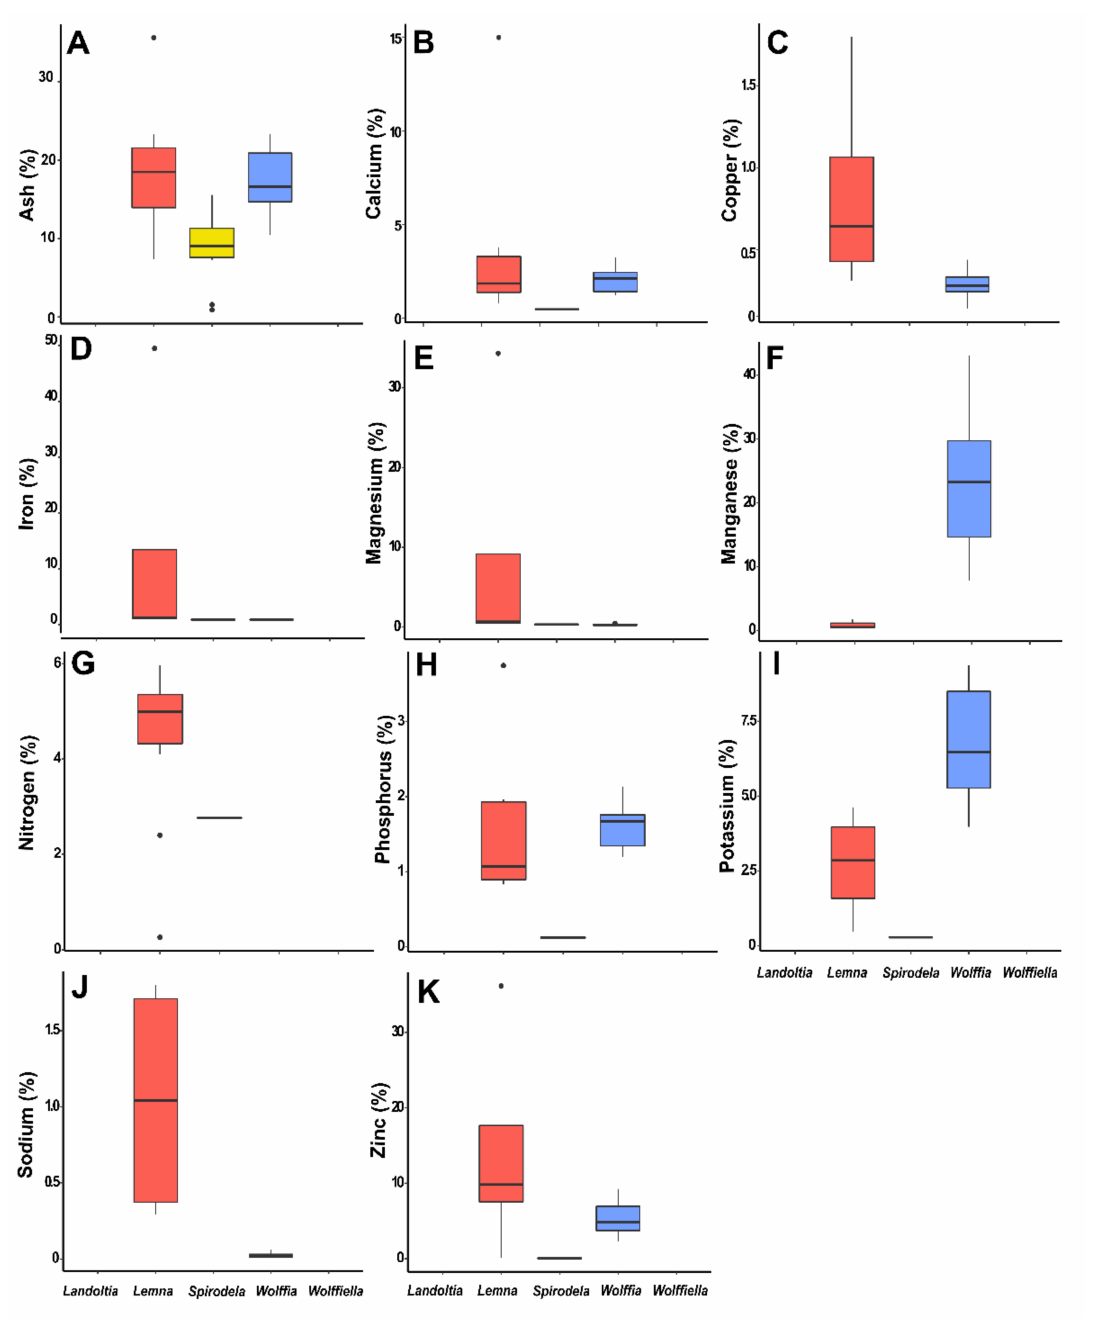
Figure 2. Ash and minerals found in duckweeds. ( A ) Ash, ( B ) Calcium, ( C ) Copper, ( D ) Iron, ( E ) Magnesium, ( F ) Manganese, ( G ) Nitrogen, ( H ) Phosphorus, ( I ) Potassium, ( J ) Sodium, and ( K )